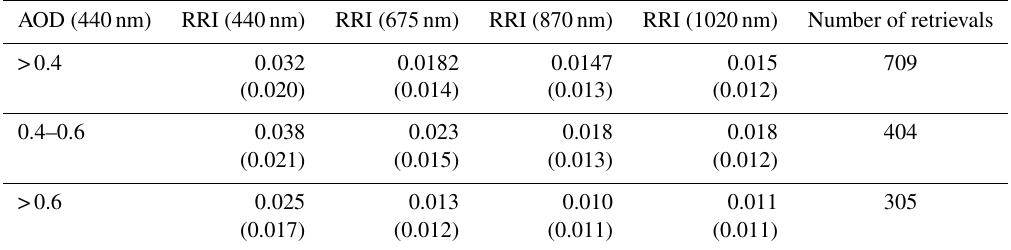
Table 5. Statistics, average values and standard deviations (in parentheses) of the difference in the RRI retrievals of V2 and V3 for the GSFC site. The difference is defined as V3 − V2.